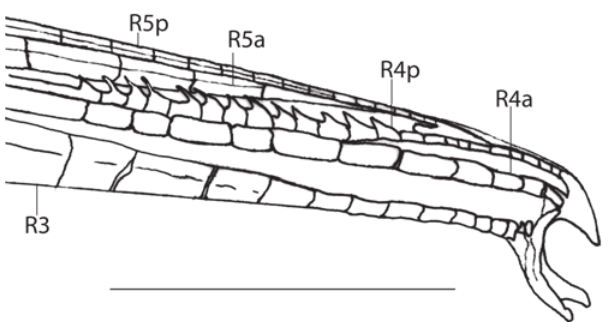
Fig. 6. Gonopodium tip of Phalloceros leticiae , MCP 30551. R3, R4a, R4p, R5a, R5p indicate gonopodial rays. Scale bar 1 mm.